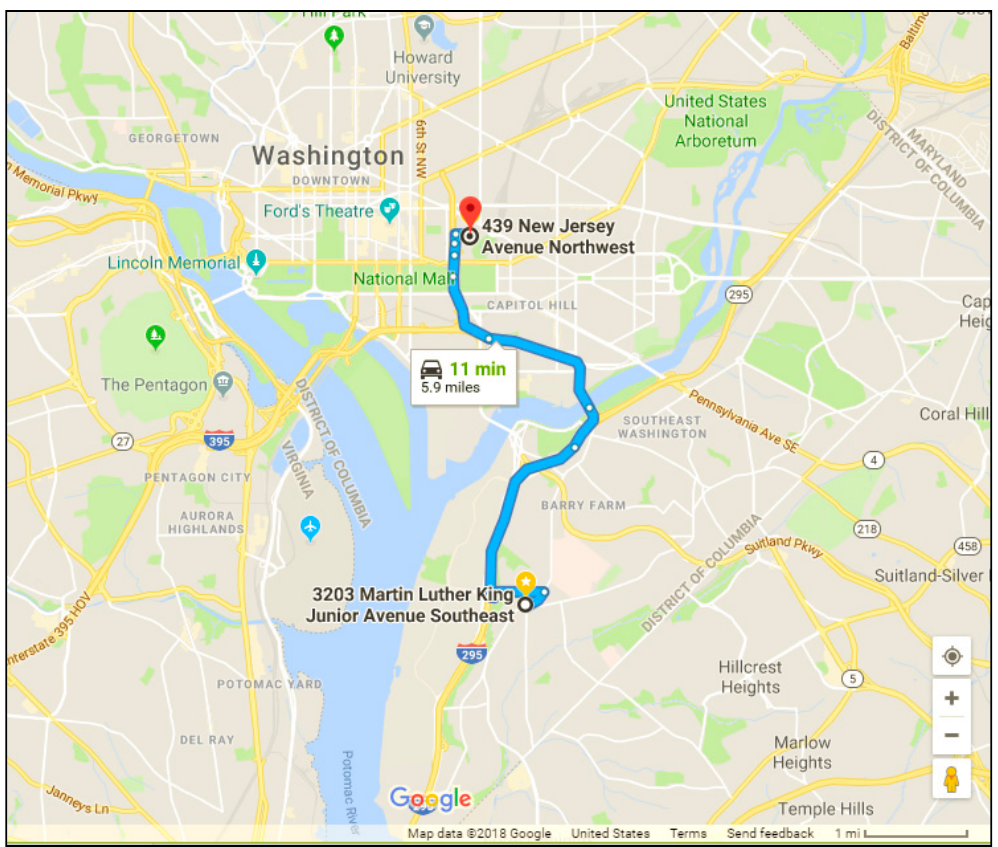
Figure 1. Study Area Map (Image from Google Maps 2018).